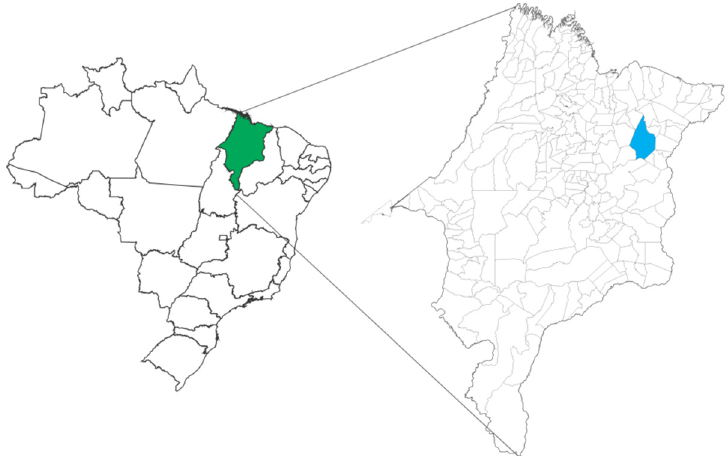
Figure 1. Maranhão State (in green) and the city of Chapadinha (in blue). Figure 1. Maranh ã o State (in green) and the city of Chapadinha (in